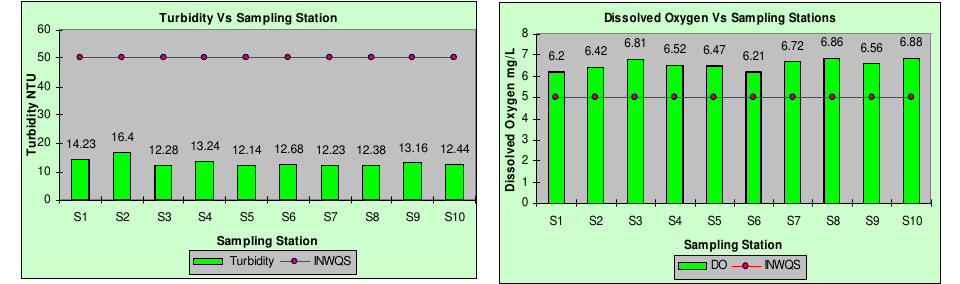
Figure 4. Dissolved Oxygen vs. Sampling Station